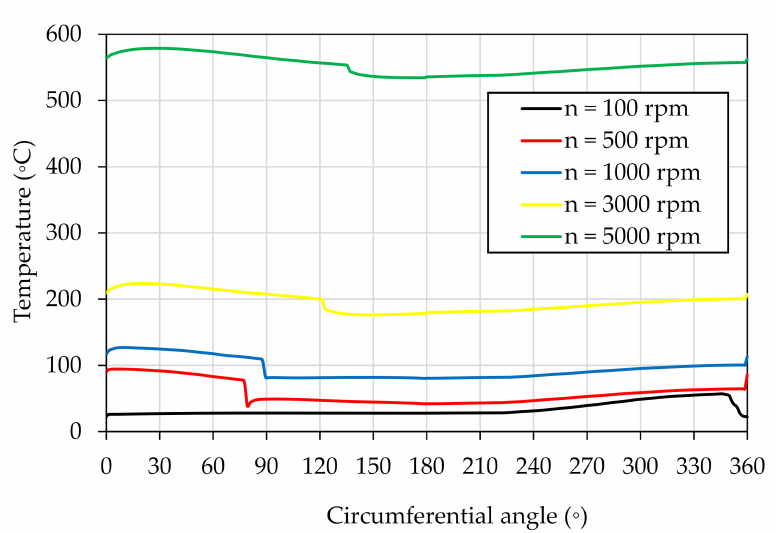
Figure 18. Temperature profile of the heterogeneous slip/no-slip bearing for different rotational velocity n . All results are evaluated at z / L =